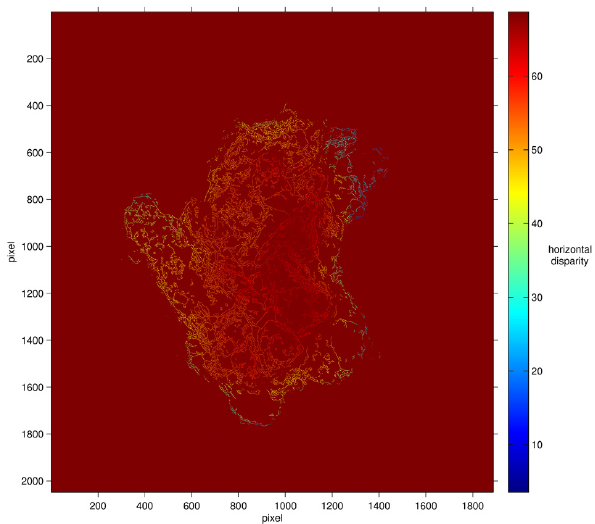
Fig. 5. Horizontal disparities reflecting the particle’s feature eleva- tion over the substrate plane at the matched points of the Agg I